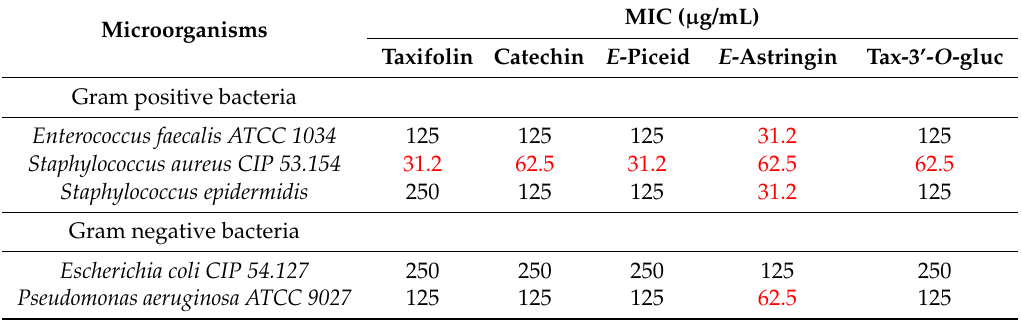
Pseudomonas aeruginosa ATCC